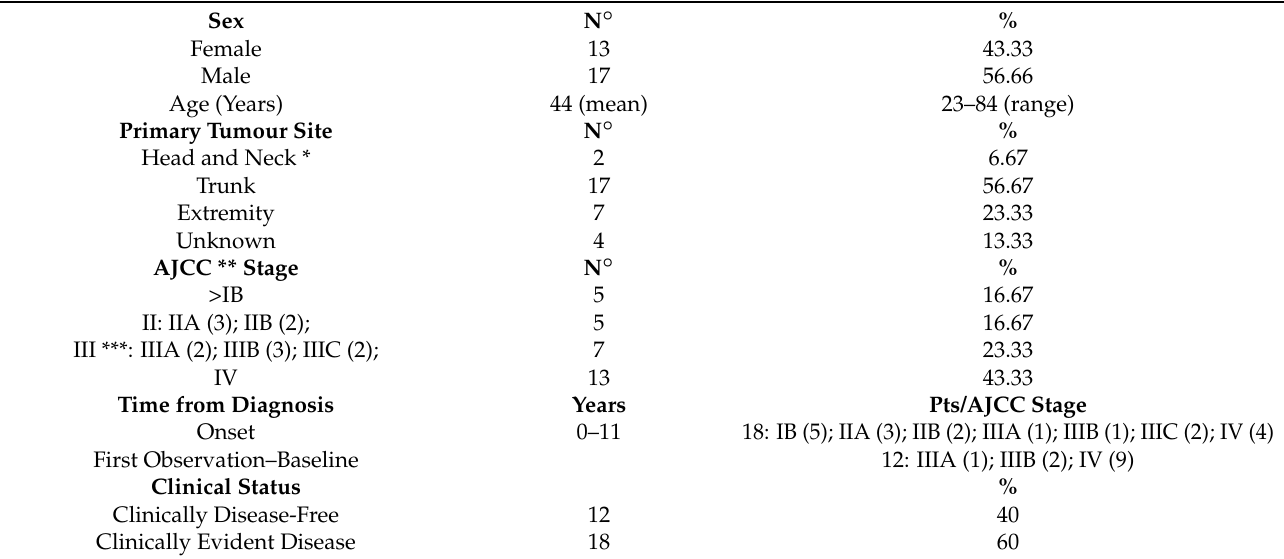
* Mucosal melanoma of the nasal cavity. ** The AJCC (American Joint of Cancer Committee) staging was evaluated at the time of the blood draw after diagnosis of primary melanomas or diagnosis of first distant metastases in the case of occult melanomas. *** Three out of five pts showed cutaneous in transit metastasis without nearby lymph node involvement